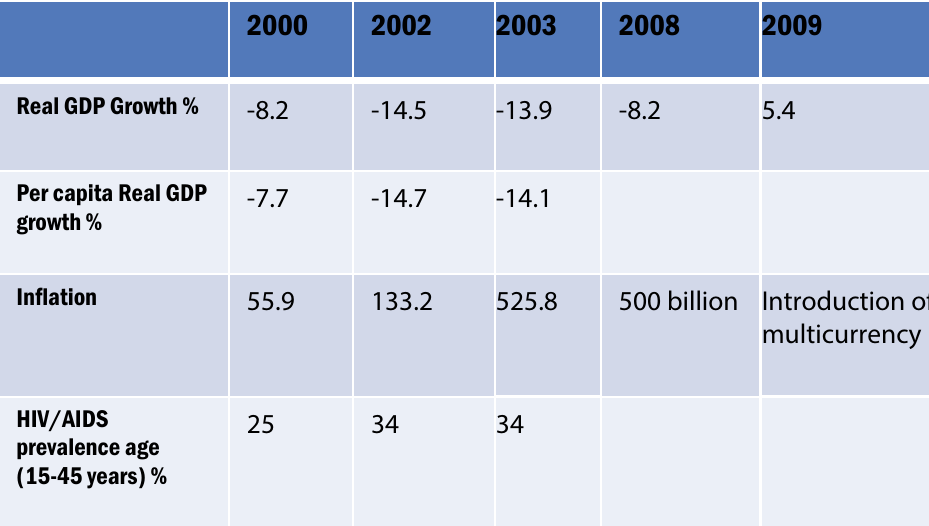
Figure 2: 2000 to 2009 Key Development Indicators